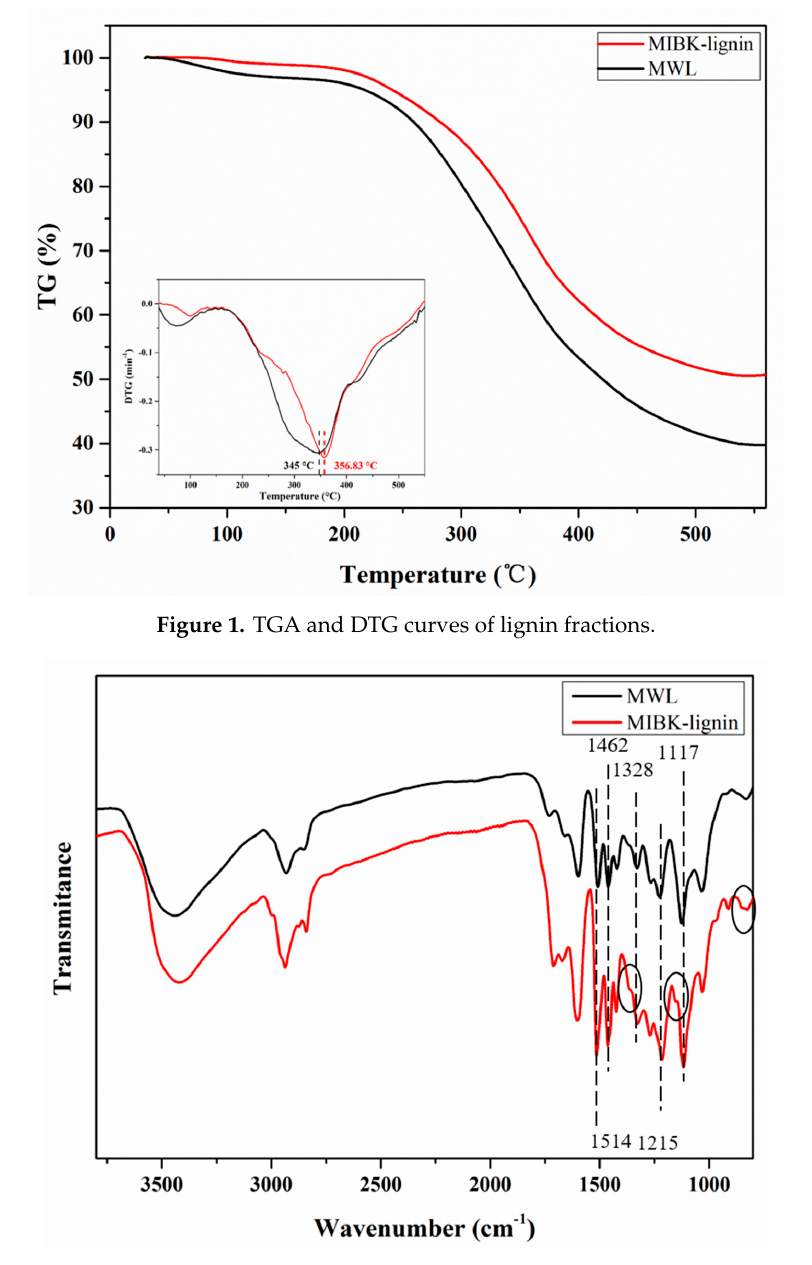
Figure 2. FT-IR spectra of lignin samples.